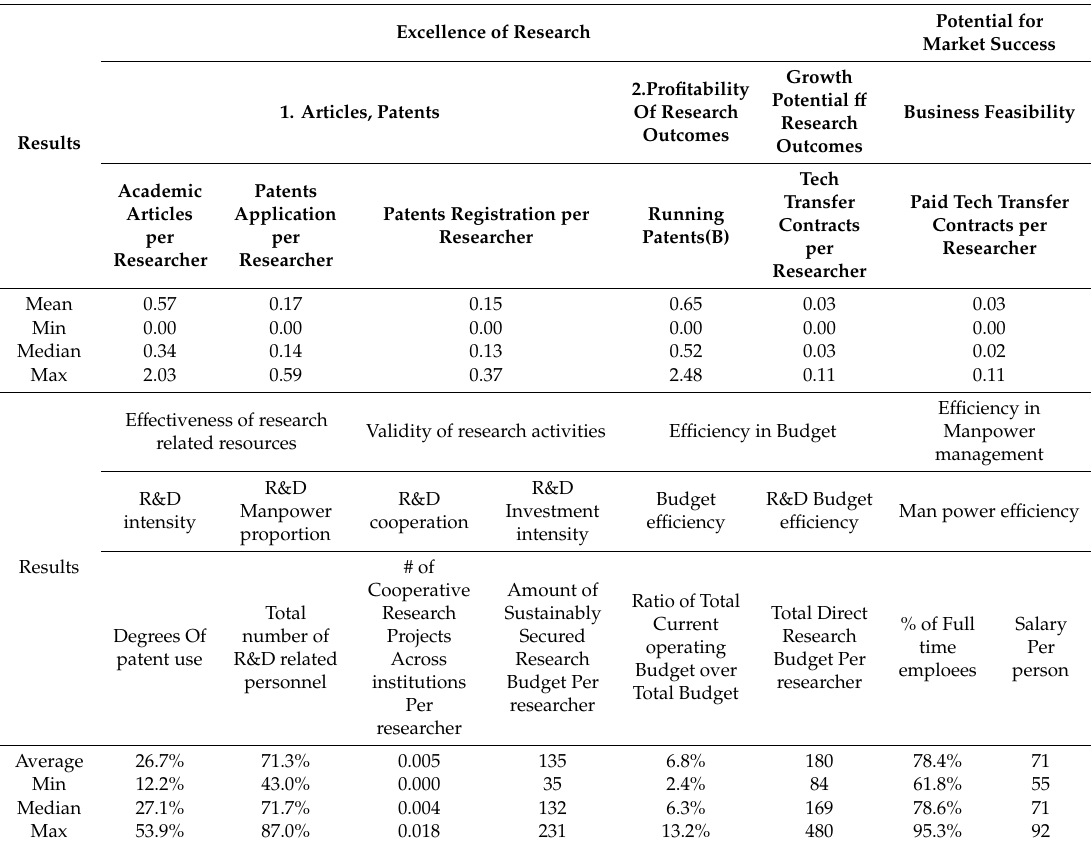
Table 4. Institutional performance